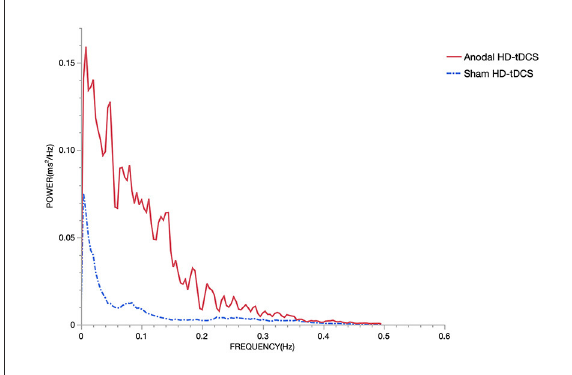
FIGURE7 Power spectrum. The sampling rate of the ECG was 1000Hz. There is an increment of the power during the stimulation using anodal HD-tDCS compared to sham HD-tDCS. The red solid line represents the anodal HD-tDCS group and the blue dashed line represents the sham stimulation